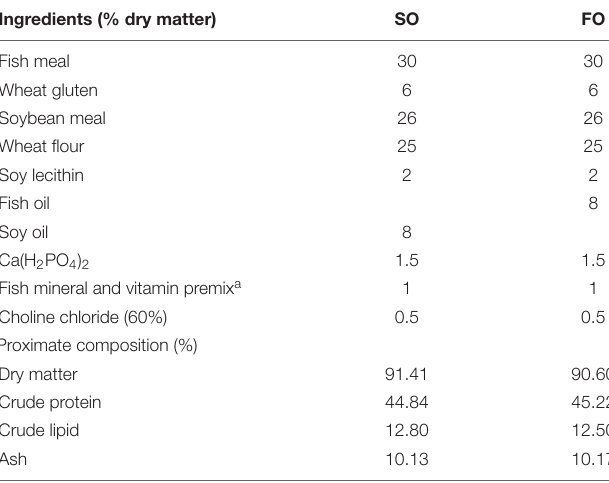
TABLE 1 | Formulation and proximate composition of experimental